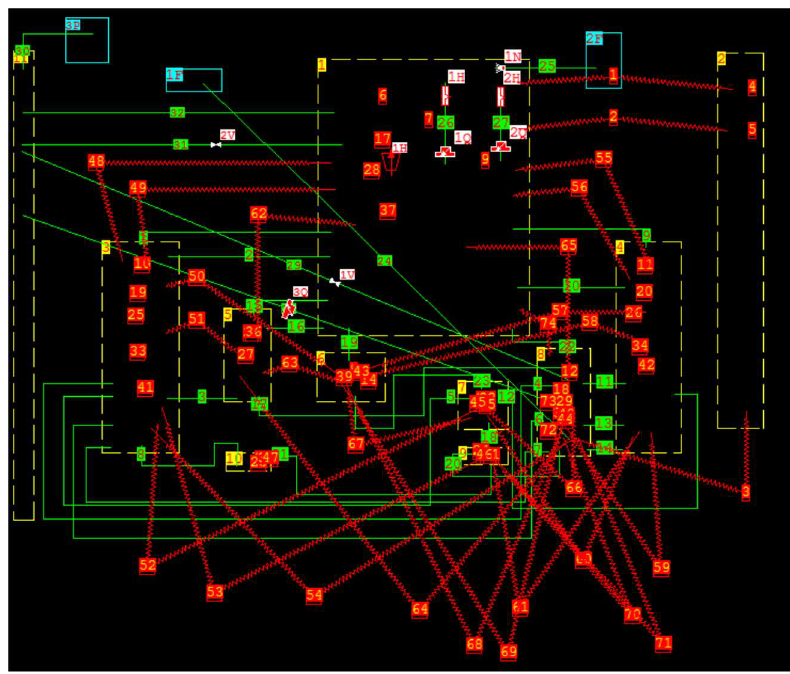
Figure 2. GOTHIC containment nodalization.